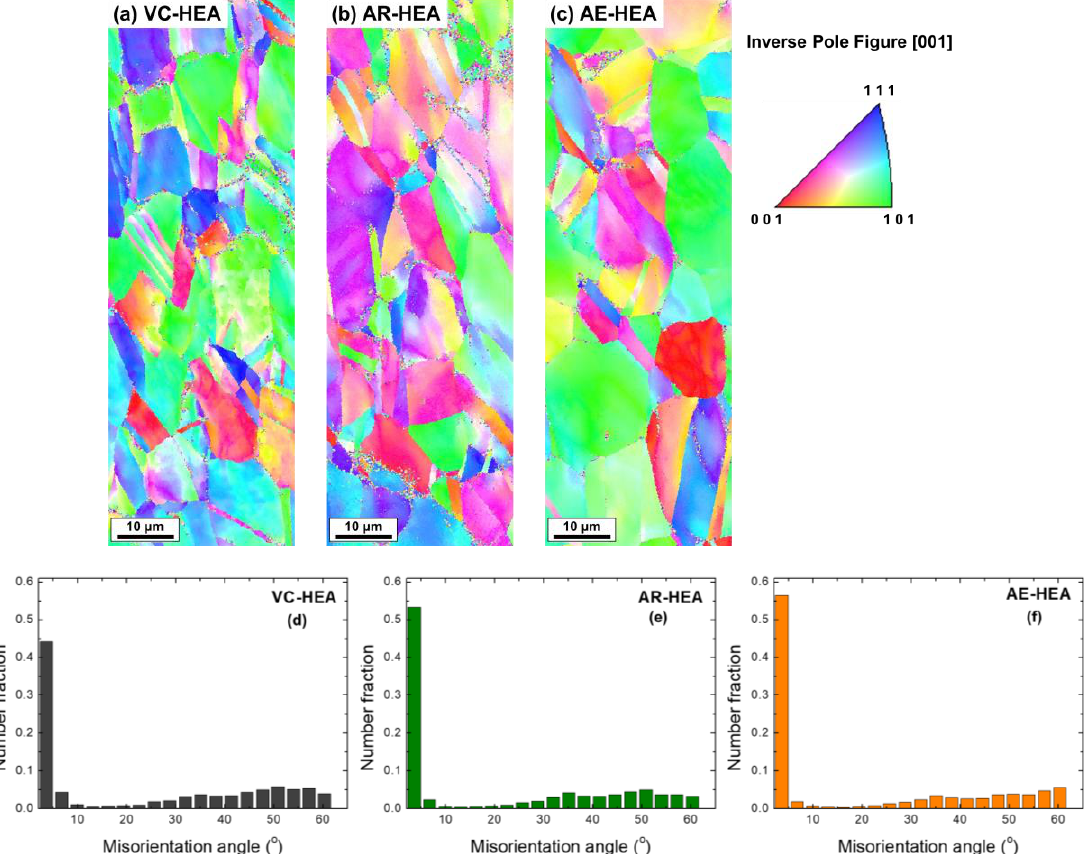
Figure 10. ( a – c ) Microstructure of the HEAs after ductile fracture. ( d – f ) Misorientation distribution of the HEAs.